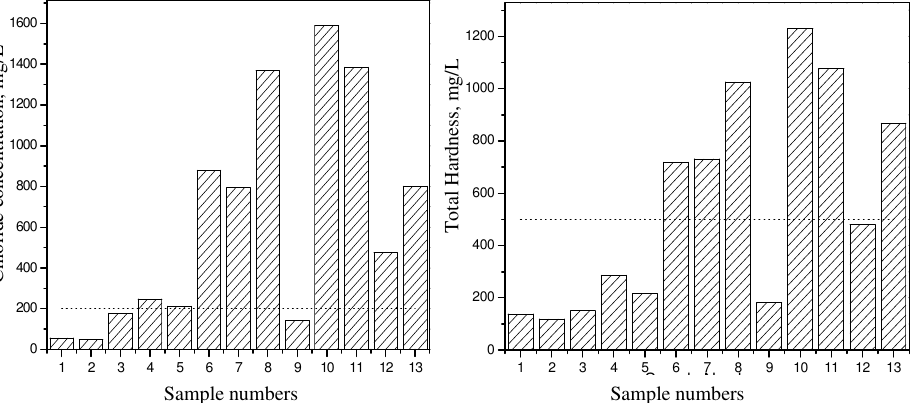
Figure 4. Total Hardness in the water samples (Dotted line indicates the permissible limit).